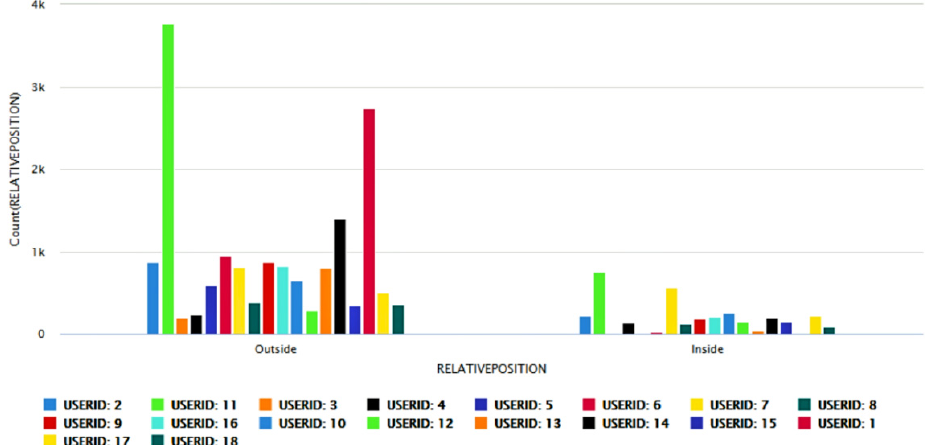
Figure 7. A bar plot representing the number of times the different users were either inside or outside a spatial region across the different floors in the different buildings, where the plot is grouped by the value of the attribute—RelativePosition.